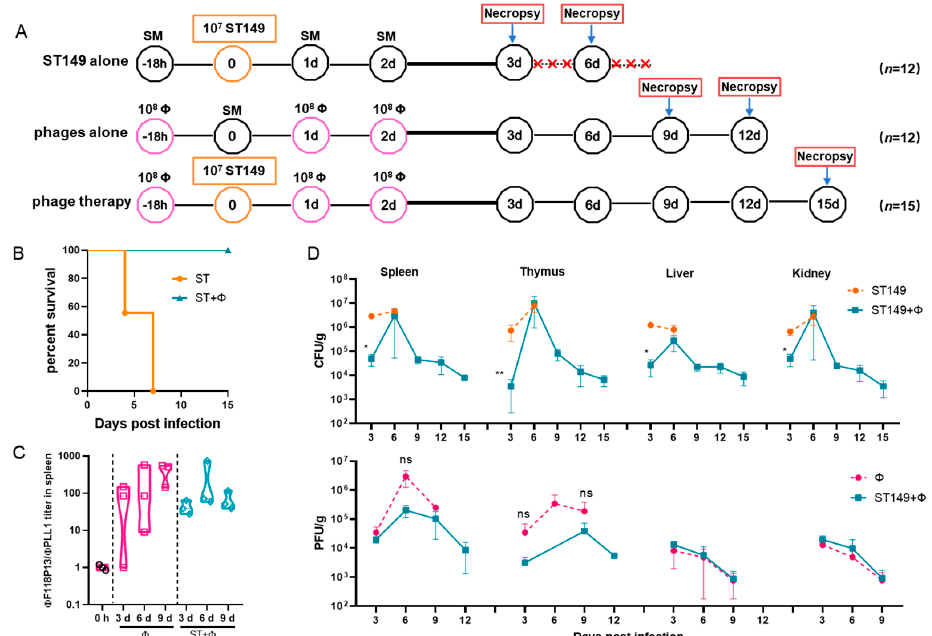
Figure 3. The phage combination protected mice against Salmonella systemic infections by inhibiting bacterial growth in organs. ( A ) Schematic depicting the experimental design, timeline, and treatment groups; × in red represents the number of dead mice. For the ST149 and phage combination control groups, 12 ICR mice were used in each group; for the phage combination-treated group, 15 mice were used. ( B ) Protection of the phage combination in infected mice. ( C ) The ratio of Φ F118P13 titer to Φ PLL1 titer in spleen in the phage alone group and the phage combination therapy group. ( D ) The bacterial load and phage titer in various organs. No data was obtained in the challenge group for 6 mice that died of Salmonella infection within 9 days. * p < 0.05 (Kruskal–Wallis test), ** p < 0.01; ns, no difference.